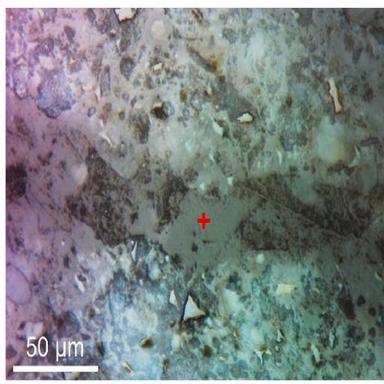
Raman spectra (a, c, e) of CH identified in cracks (red cross) shown in optical micrographs (b, d, f) from samples and CA dosages of: 0% CA (a and b); 1% CA (c and d); and 2% CA (e and f). (For interpretation of the references to colour in this figure legend, the reader is referred to the Web version of this article.)